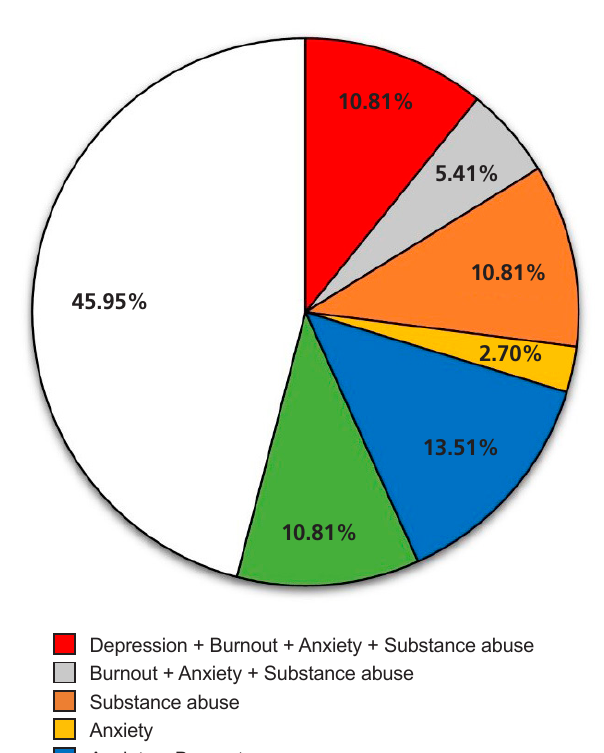
Fig. 2 - Presence of any change in the assessment of mental